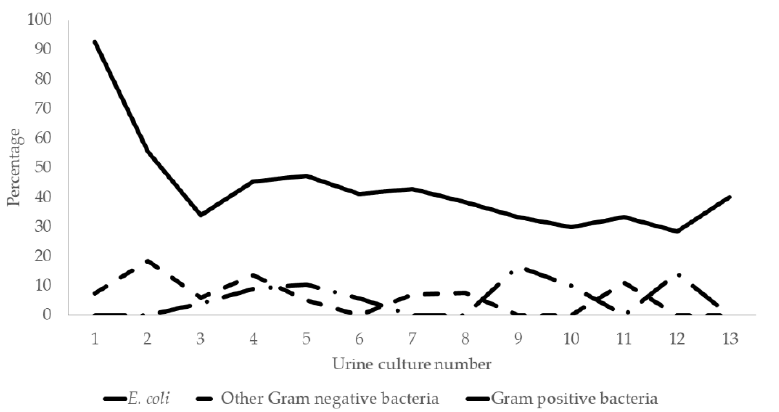
Figure 1. E. coli and other bacteria isolated from urine samples from children with complicated UTI and treated with ABL.